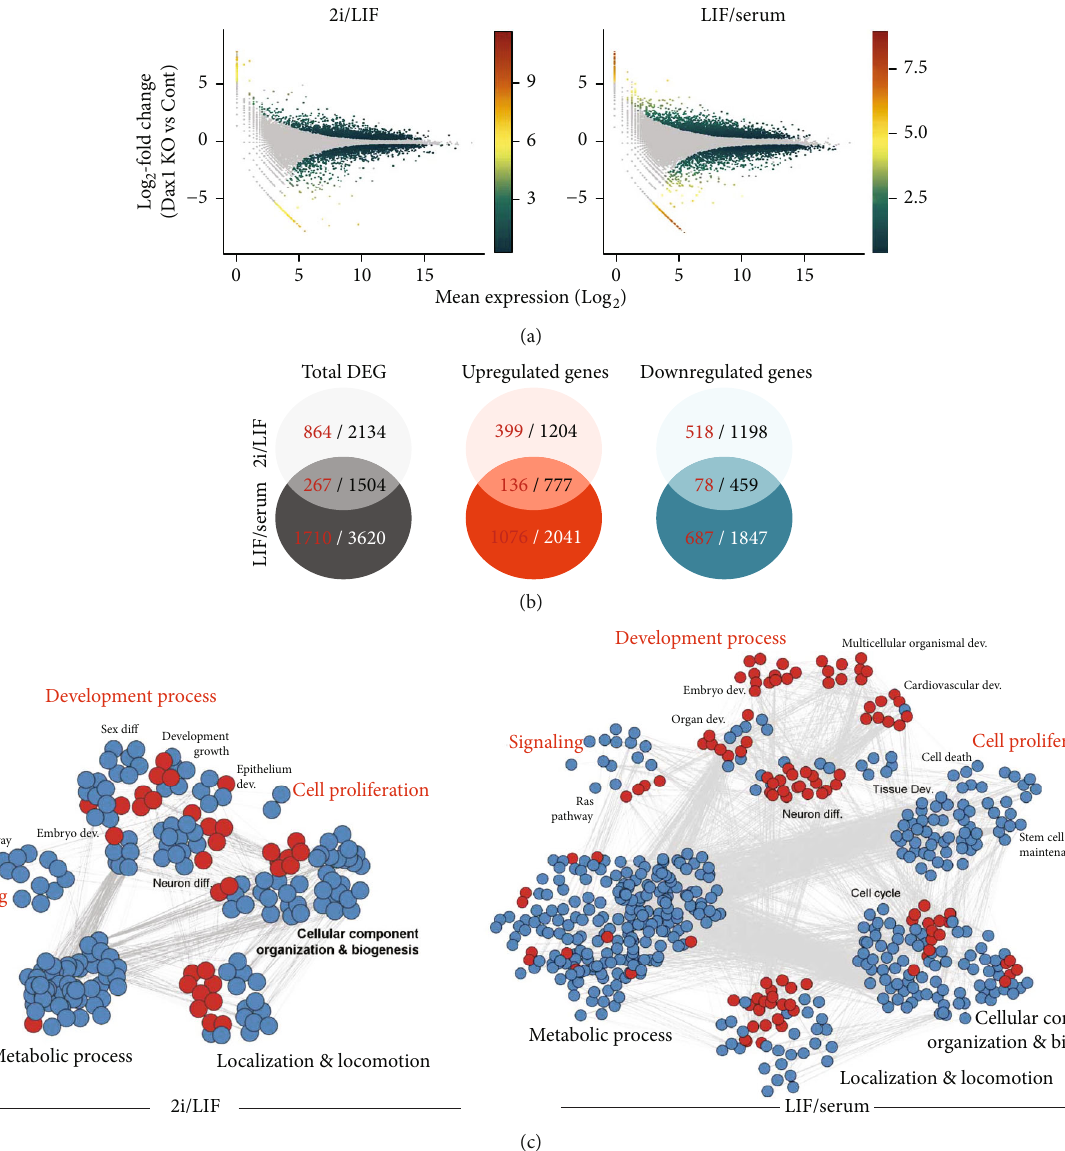
Figure 4: The global transcription pro fi les of Dax1KO cells in 2i/LIF and LIF/serum culture. (a) Scatterplots showing di ff erentially expressed genes (DEGs) from Dax1 KO compared to wild-type ESCs cultured in 2i/LIF (left) and LIF/serum (right) medium. Grey dots are unaltered genes. Colored dots are signi fi cantly up-/downregulated genes in Dax1 KO cells with DESeq2 p (adj) ≤ 0.05, absolute value of fold change ≥ 1.2, the color of the dot correspond to the absolute value of fold change (red is high and blue is low). (b) Venn diagrams represent overlapped total DEGs (left), upregulated genes (middle), or downregulated genes (right) in Dax1 KO cells between 2i/LIF and LIF/serum medium. The red letters indicate the number of the DEGs with absolute fold change ≥ 2, and the black/white letters indicate the number of the DEGs with absolute fold change ≥ 1.2. (c) Enrichment map networks of GO terms corresponding to DEGs with absolute fold change ≥ 1.2 (blue) or DEGs with absolute fold change ≥ 2 (red) in Dax1 KO versus wild-type mESCs cultured in 2i/LIF (left) and LIF/serum (right) medium. Gene Ontology was analyzed by g: pro fi ler, and visualized by the cytoscape plug-in: enrichment map. Nodes represent GO terms; edges connect nodes that share common